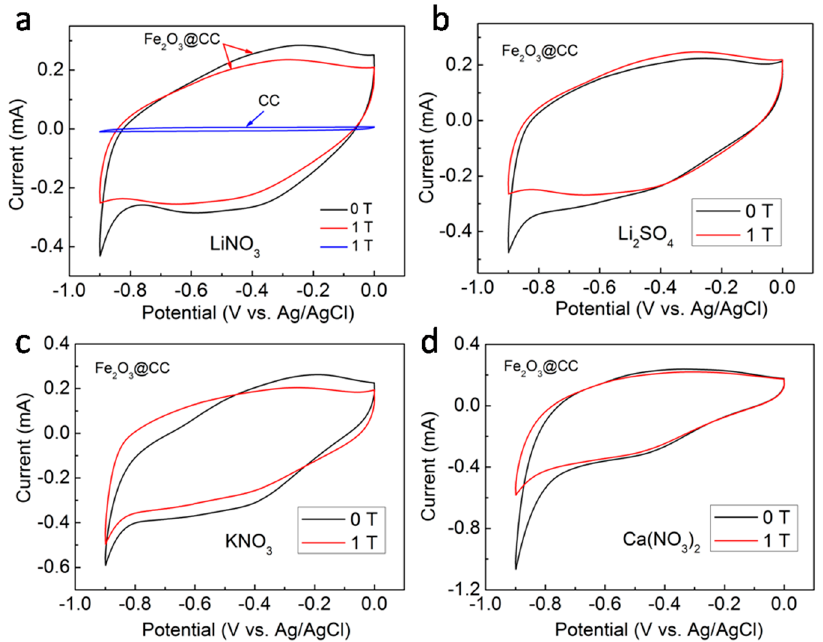
Figure 3. CV curves of the Fe 2 O 3 @CC and CC electrodes with or without magnetic field in various aqueous electrolyte: ( a ) LiNO 3 , ( b ) Li 2 SO 4 , ( c ) KNO 3 , and ( d ) Ca(NO 3 ) 2 .